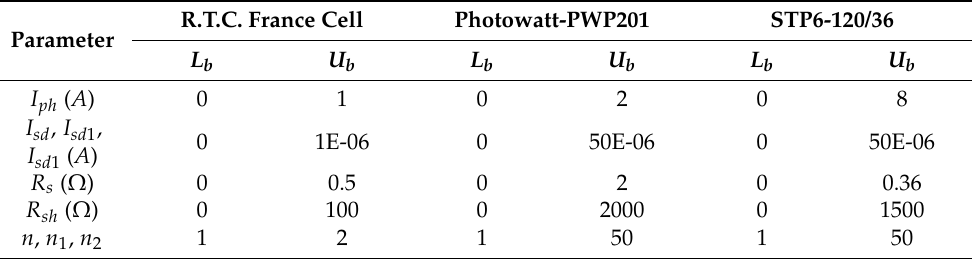
Table 3. The search boundaries of each unknown